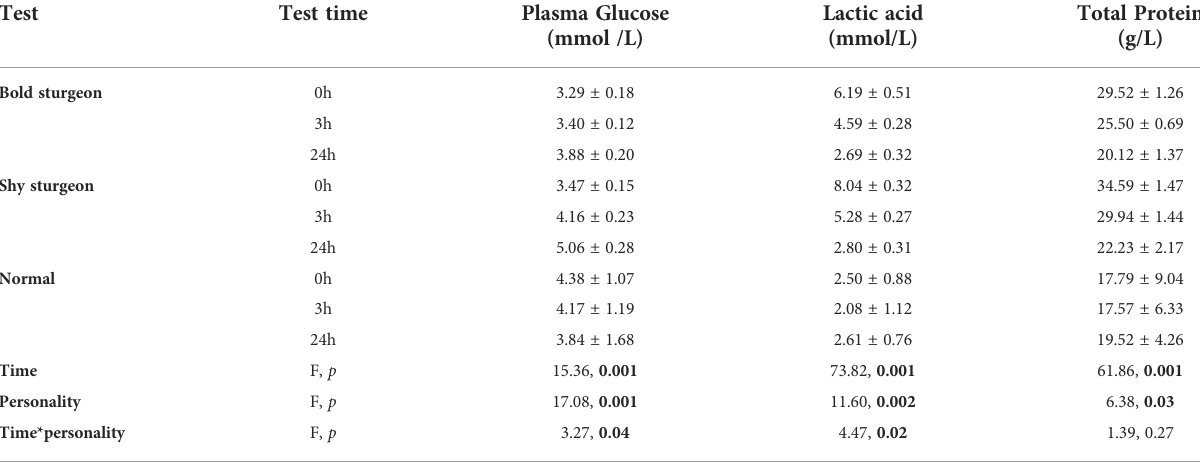
Statistically signi fi cant outcomes are shown in bold. This symbol of “ * ” represents the interaction between personality and test